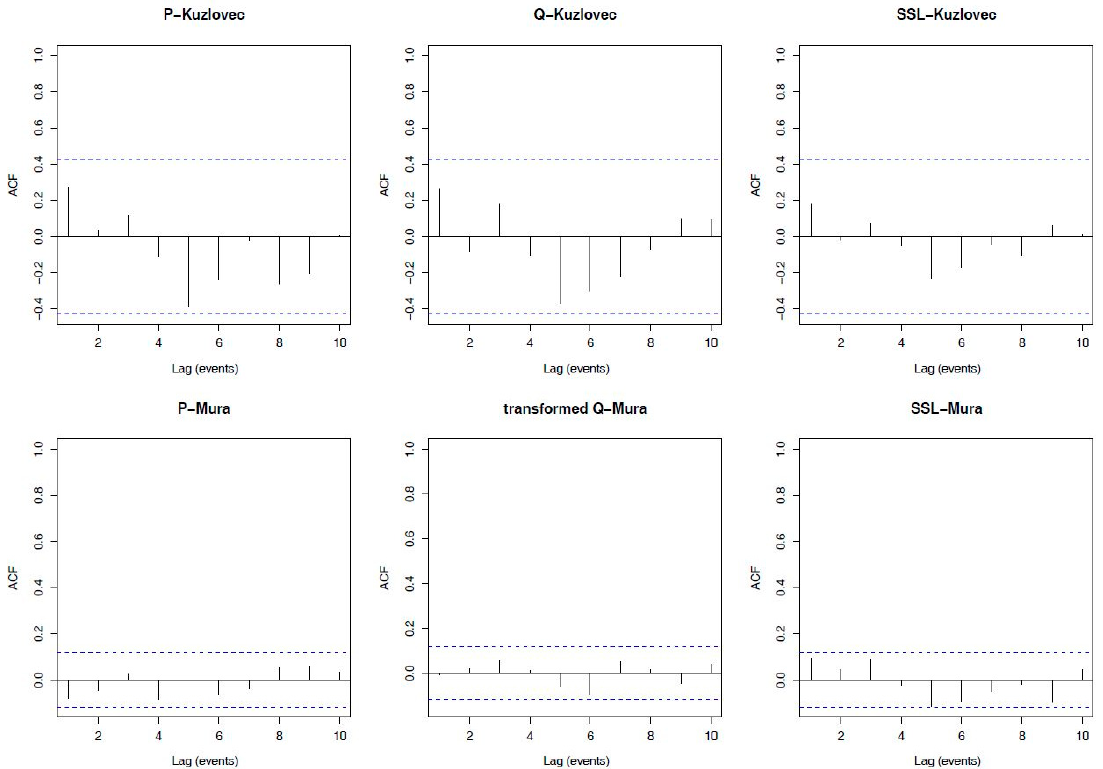
Figure 3. Autocorrelation plots for the data from the Kuzlovec torrent (upper plots) and Mura River (lower plots) where for the Q series for the Mura case the transformed data are showed.